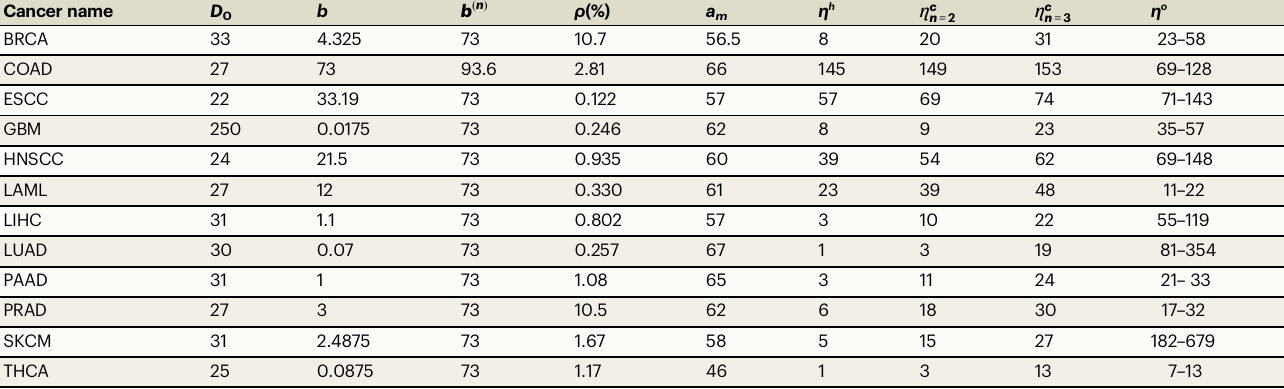
For12cancertypesandassociatedtissue(seeTable2forthemeaningoftheabbreviations),(a) parameterestimatesobtainedfromtheliterature (columns1 – 4): D 0 numberofdivisionsduringthetissue developmentphase, b and b n ð Þ yearlynumberofdivisionsinahealthyandincancertissue, ρ proportionofthepopulationthatgetscancerbyage80,(b) data (columns5and9): a m medianageofthe TCGAdatabasecancerpatients, η o interquartileintervaloftheactualobservednumberofsomaticmutationsfoundinthetissueofcancerpatientsaged a m − 5to a m +5,(c) valuescomputedfromour (cid:1) (cid:3) (cid:1) (cid:3) model (columns6 – 8): η h = η h a m (resp. η c = η exp a m ) expected number ofsomatic mutations foundinthetissue ofa healthyindividual (resp. cancer patient)aged a m in the absence of E and